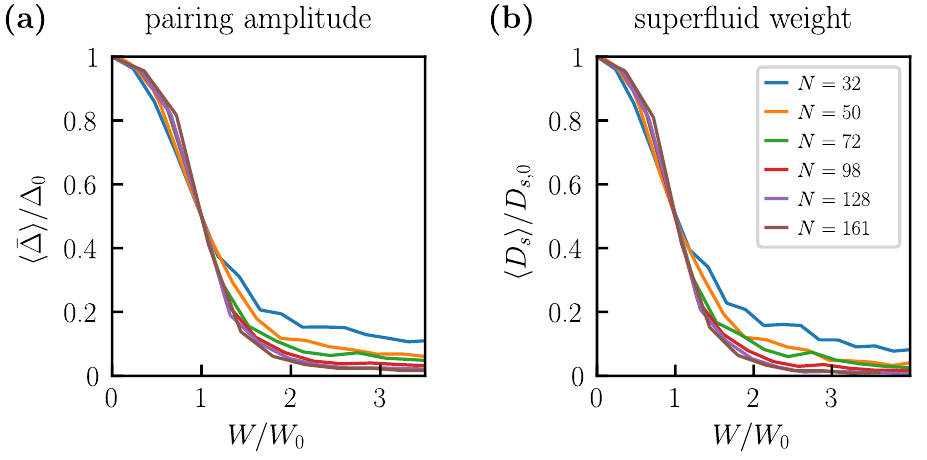
Figure 9: Disorder-induced suppression of the pairing amplitude and the superfluid weight for different cluster sizes. We show results for the extended Kane-Mele model / 100, and ¯ ν = 1 / with flat lower band and U = 3 t , T = T c ,0